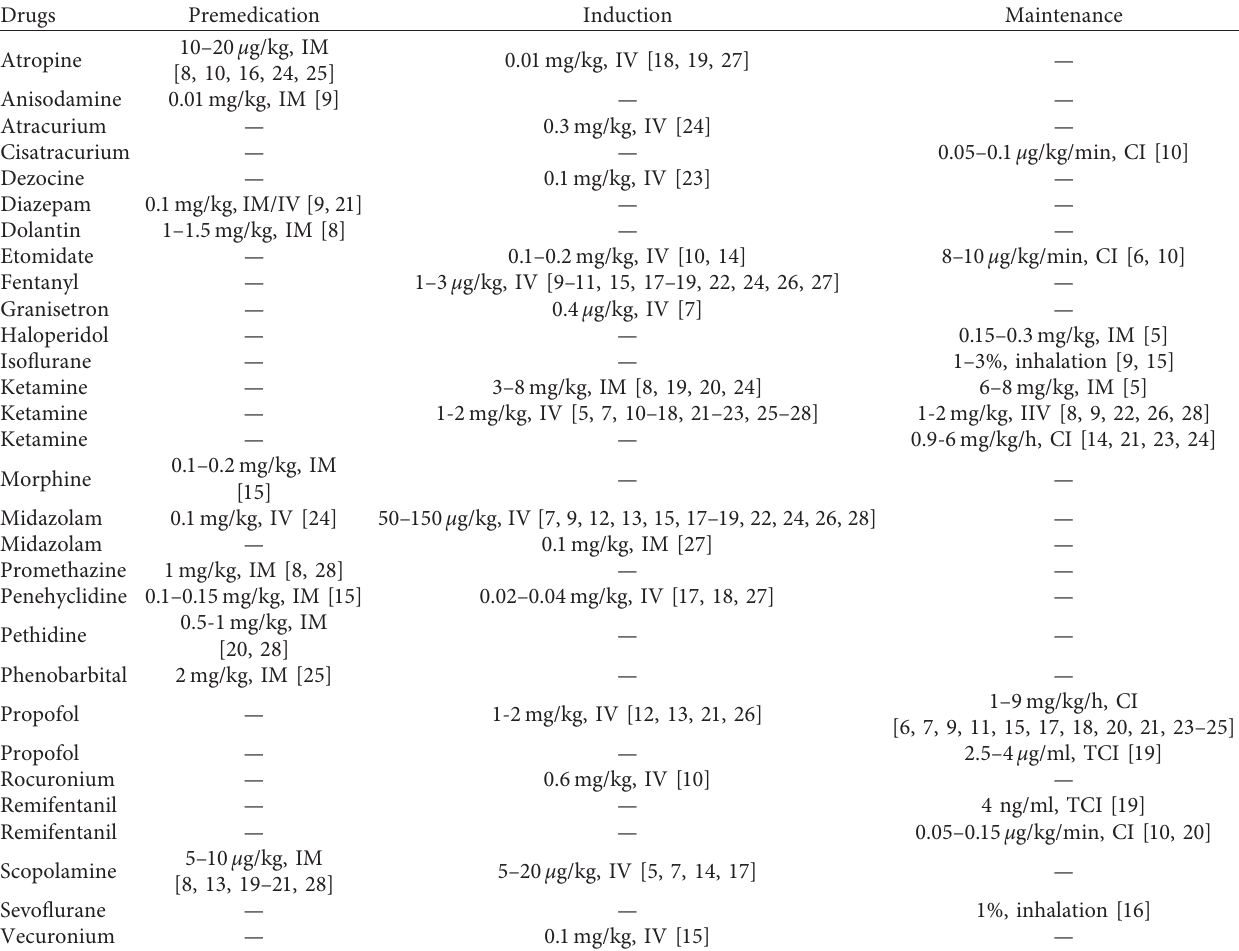
Table 3: Drugs used in anesthesia for cardiac